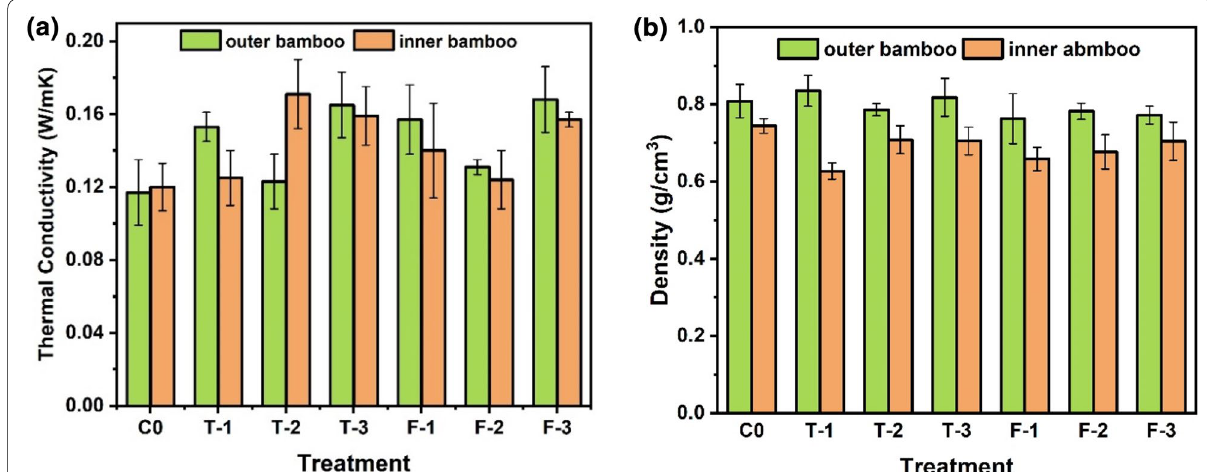
Fig. 6 Thermal conductivity and density of outer and inner bamboo after freeze–thaw treatment with different moisture content. (The error bars refer to the standard deviation which reflects the degree of dispersion of the value relative to the